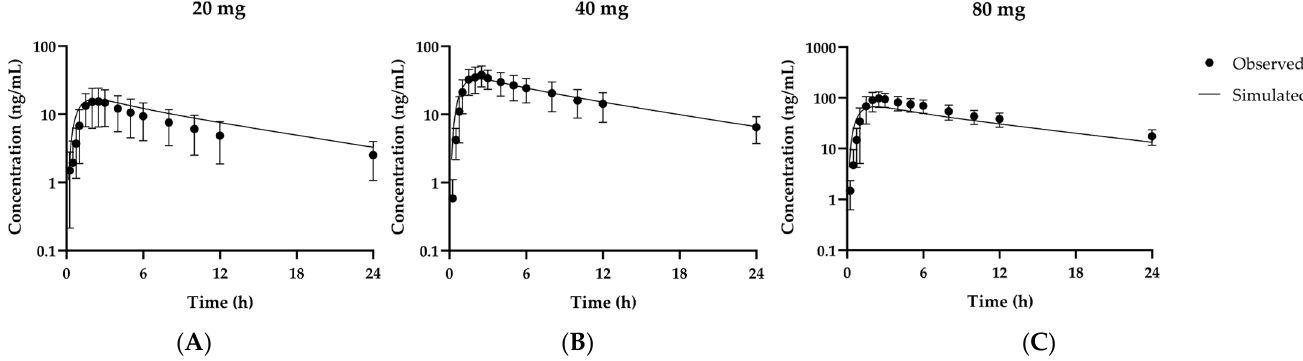
1 Observed data from the registered clinical trial in healthy volunteers (registered at ClinicalTrials.gov as NCT02757144 [10,22] ). The observed value is the average value of the pharmacokinetic parameters obtained from the data of eight people. 2 Observed data from the registered clinical trial among Korean, Caucasian, and Japanese (registered at ClinicalTrials.gov as NCT03574415 [1,23] ). The observed value is the average value of the pharmacokinetic parameters obtained from the data of 24 people.